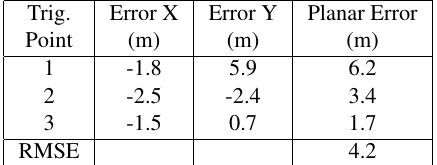
Table 2. The LSA fit error of all test cases in Attiki test site.